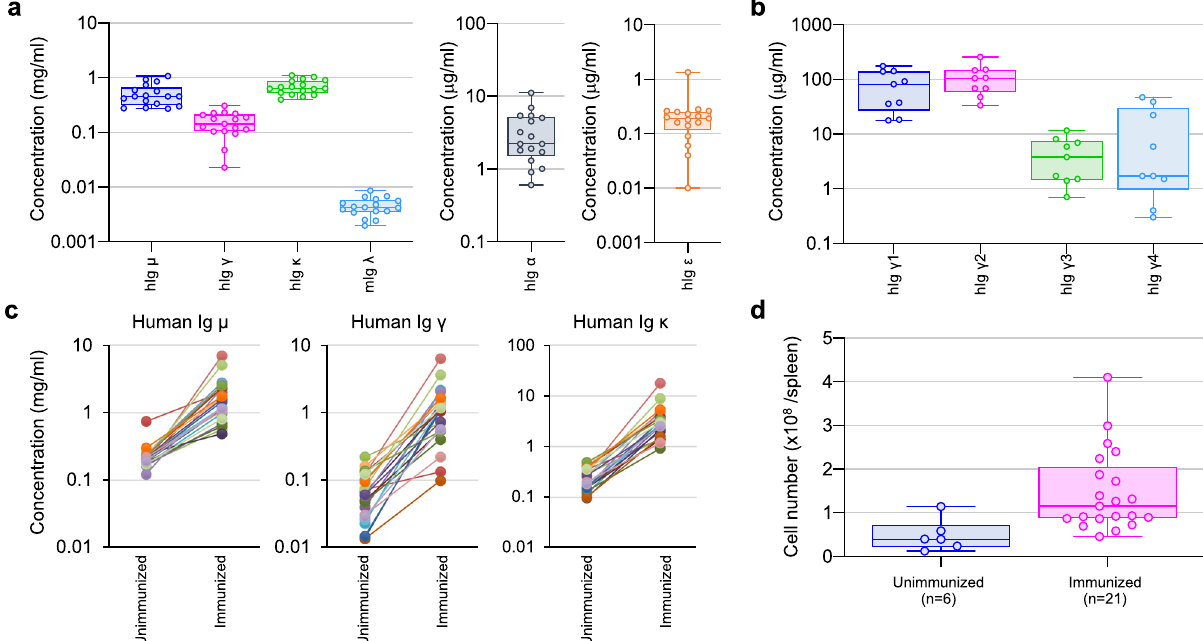
Fig. 5 Production of human Ig in TC-mAb mice. a The serum concentration of different classes of human Igs in 15-week-old TC-mAb mice. The concentration of hIg μ , hIg γ , hIg κ , mIg λ , hIg α and hIg ε in TC-mAb mice ( n = 17) was measured. b The serum concentration of human IgG subclasses. The concentrations of Ig γ 1, 2, 3 and 4 were measured in 15-week-old TC-mAb mice ( n = 9). a , b Each symbol represents one serum concentration. c The serum concentration of hIg μ , Ig γ and Ig κ before and after immunization of TC-mAb mice. The symbols collected from the same mouse before and after immunization are connected by a line. d The number of lymphocytes. The numbers of harvested cells were counted under Turk ’ s solution. Each symbol indicates one mouse. Box plots are indicated in terms of minima, maxima, centre, bounds of box and whiskers, and